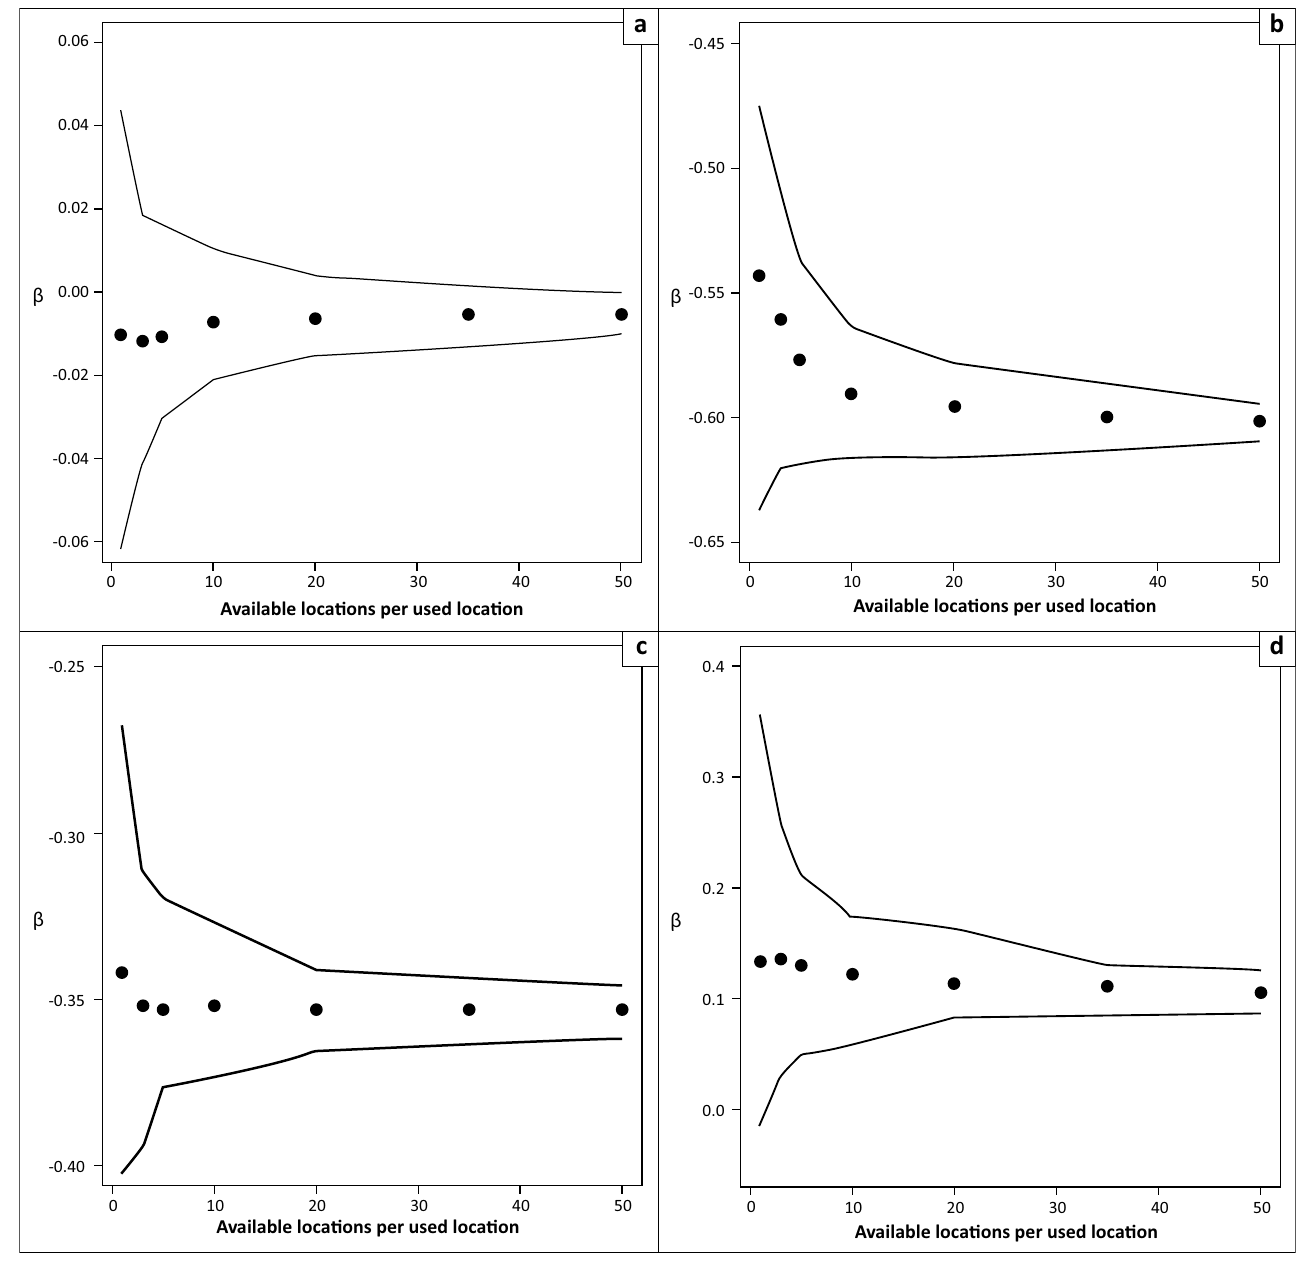
FIGURE 2-A3: Coefficient estimates (black points) and 95 % simulation envelopes (solid lines) for (a) Normalised Difference Vegetation Index, (b) distance to water, (c) slope and (d) terrain ruggedness, calculated from 100 conditional logistic regression models fit to varying ratios of available to used elephant locations recorded at